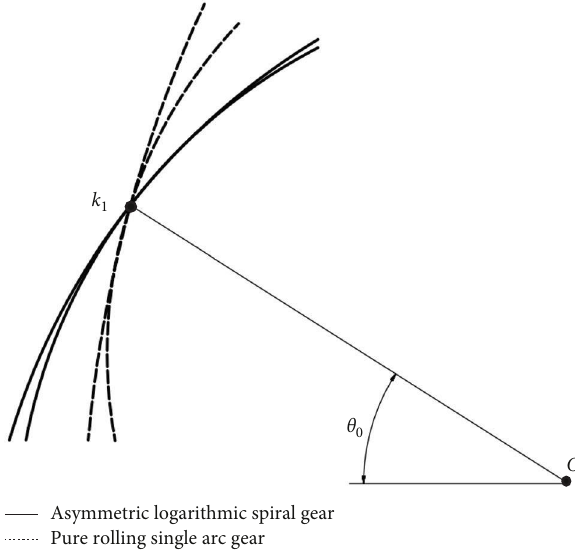
F IGURE 22: Comparison of the gears tooth